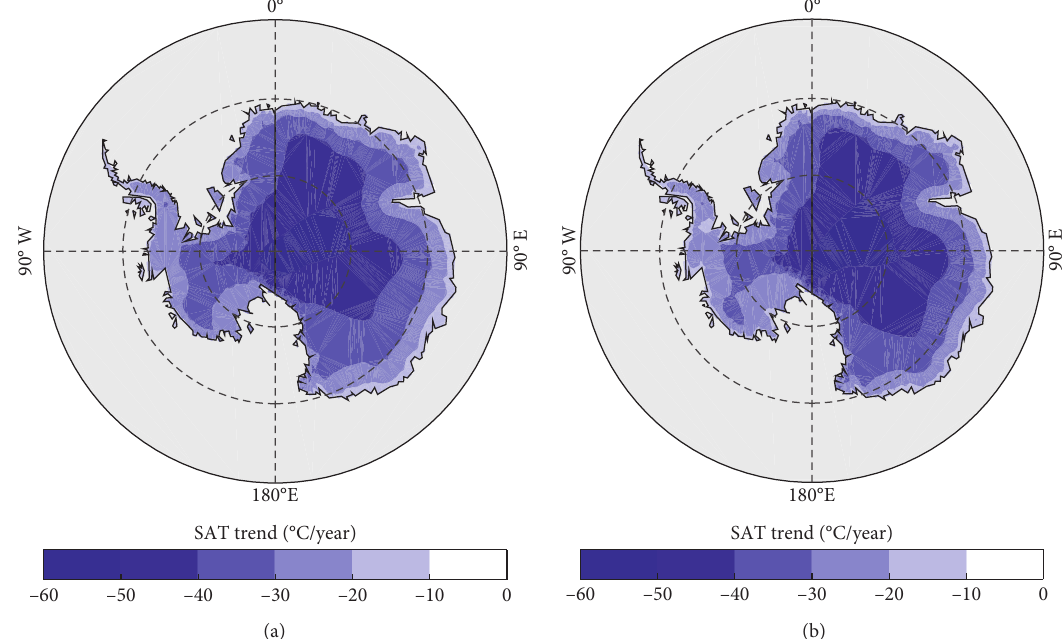
Figure 7: Spatial distributions of the mean SAT fields during (a) 1960–1989 and (b) 1990–2019, respectively. These two 30-year periods denote two distinct climatologies.